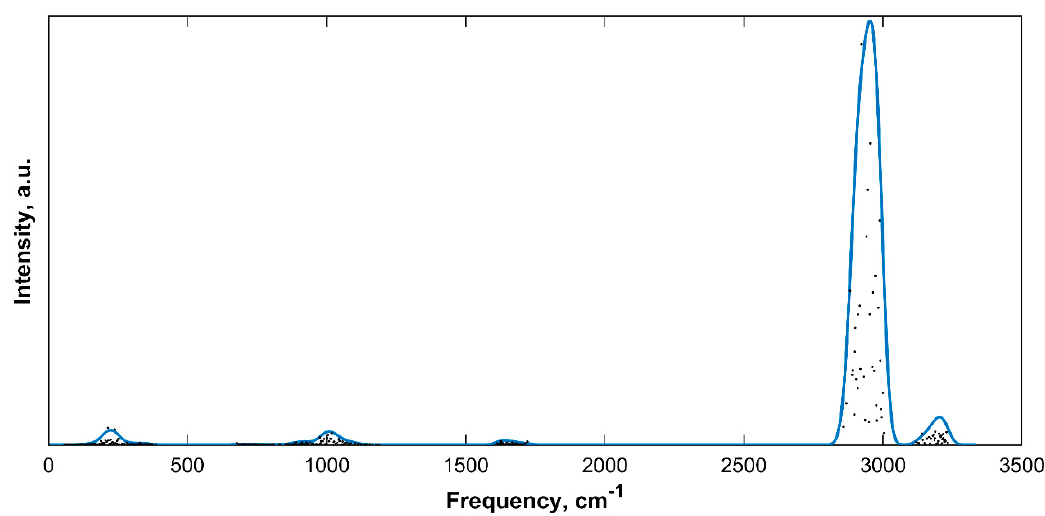
Table 1. Structural characteristics of structure-H (sH) hydrates, a-lattice and c-lattice constants, unit cell volume (V), oxygen-oxygen (O···O) distance, hydrogen bond (O···H) length, and the covalent bond (O-H) length at 0 K and 0 GPa.